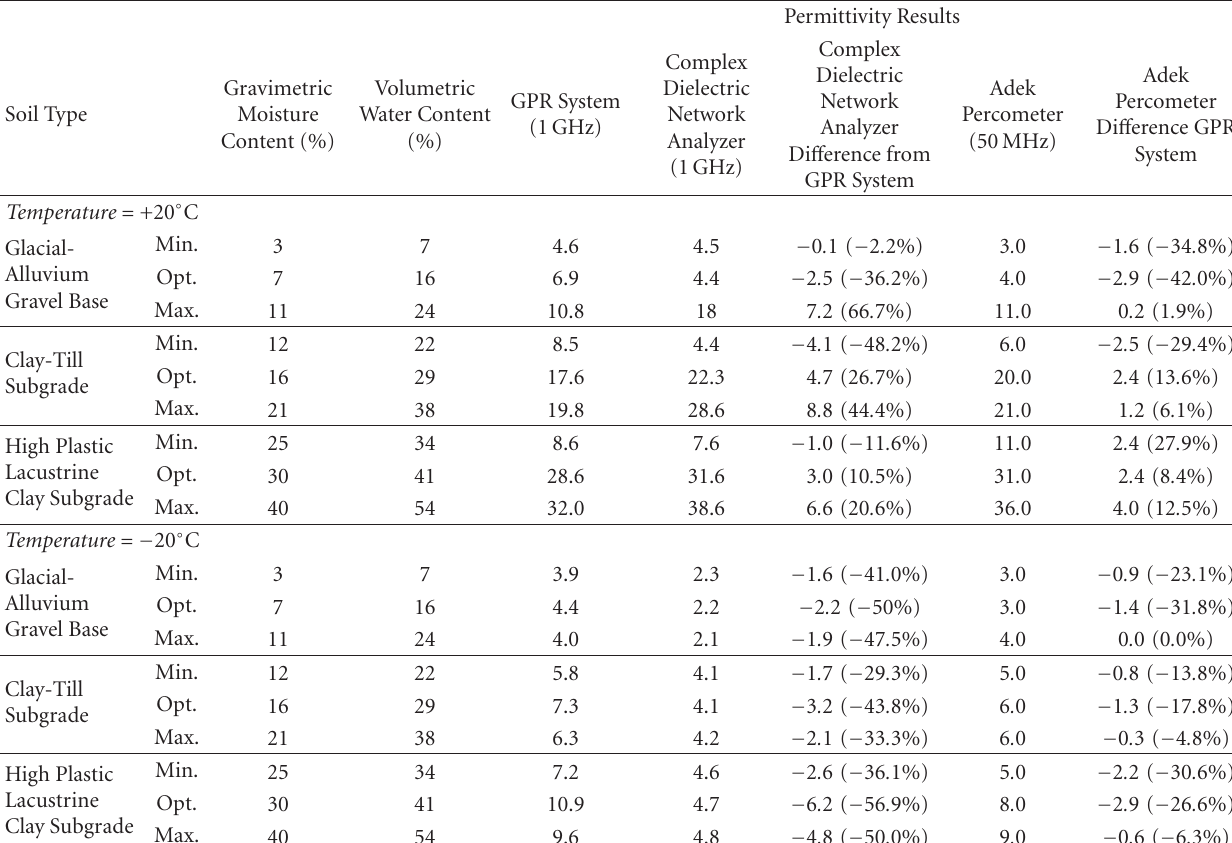
Table 3: Summary of Permittivity Results at +20 ◦ C and − 20 ◦